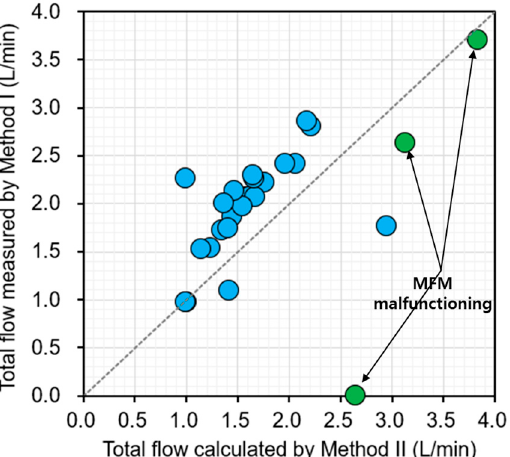
Figure 6. Gas flow relation between Methods I and II with respect to syngas generation.